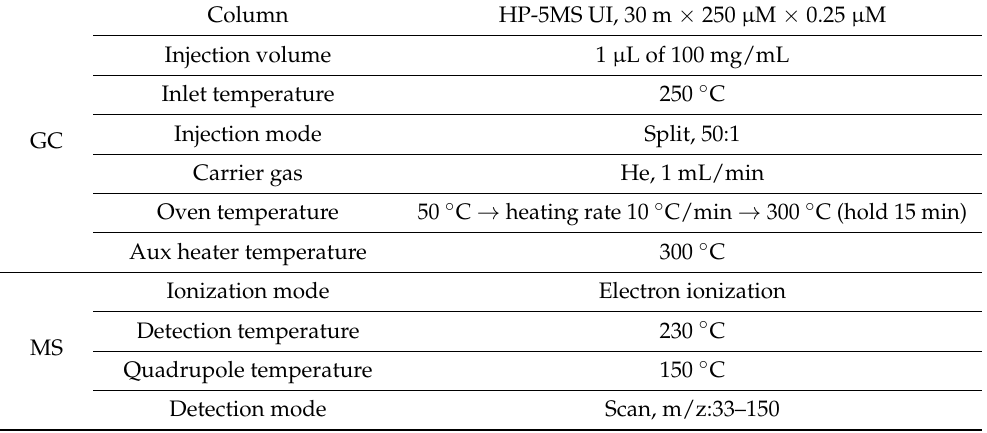
Table 2. Detailed conditions of the GC–MS